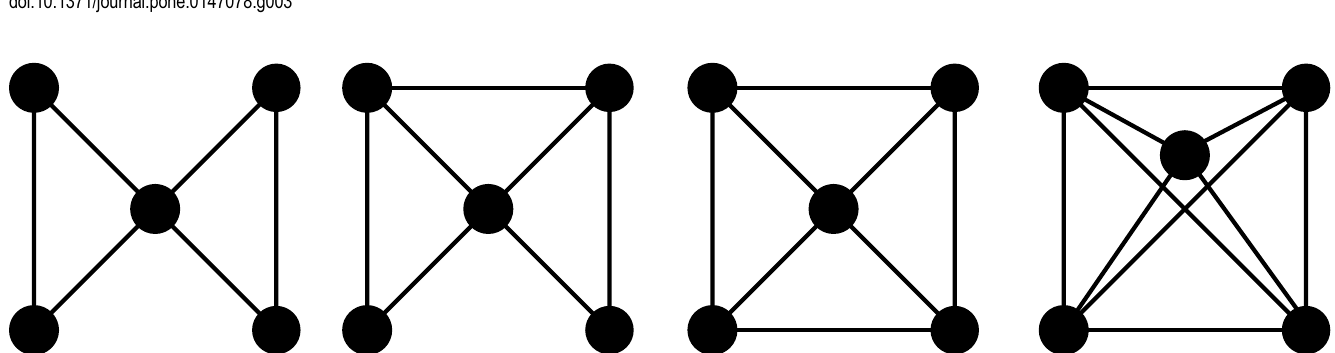
Fig 3. The number of graphlets for each order. The logarithm of the number of graphlets is plotted against the number of vertices in each graphlet. The curve is an exponential fit: f ( n ) = 0.022 n 2.50 , which has a coefficient of determination R 2 = 0.9989.